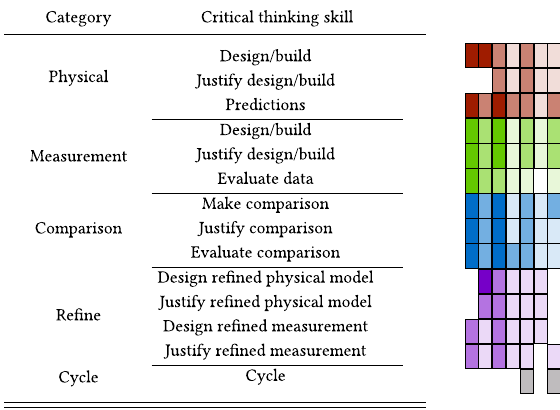
FIG. 7. Alternative case for effectively teaching critical think- ing skills through deliberate practice. Each box represents one half of a two-week lab activity with the first week providing less available agency compared to the second